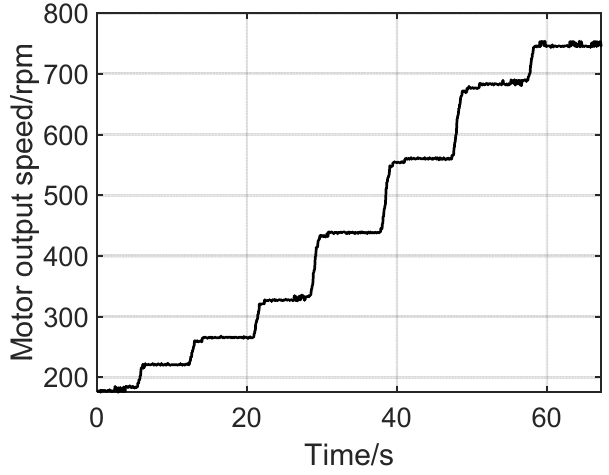
Figure 8. Measured output speed of constant motor.